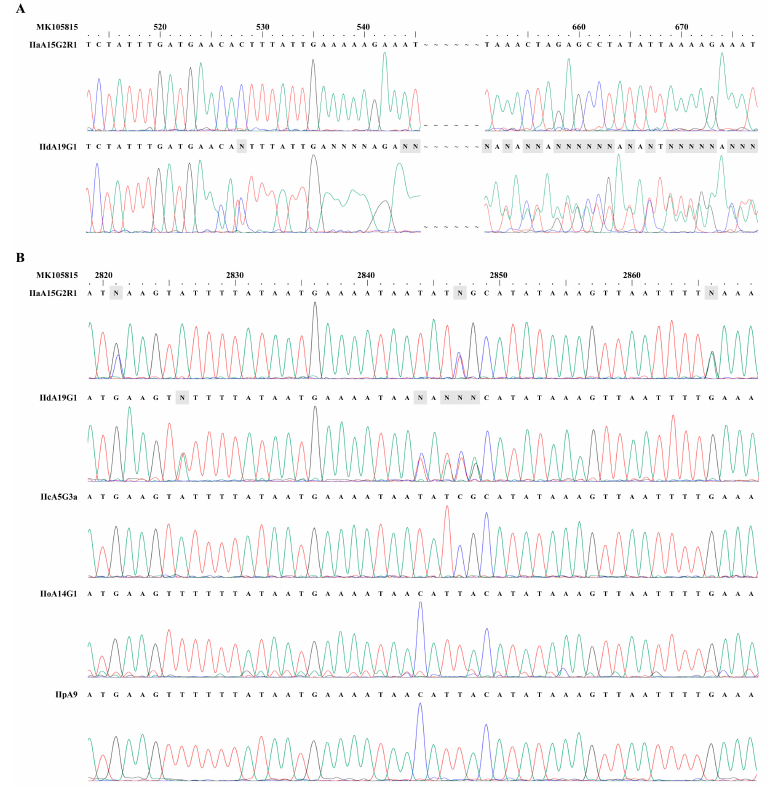
Figure 1. Presence of dual copies of the cgd6_5520-5510 gene in Cryptosporidium parvum IIa and IId subtypes. ( A ) Sequencing trace files of PCR products of the 5 (cid:48) end from the gene in C. parvum